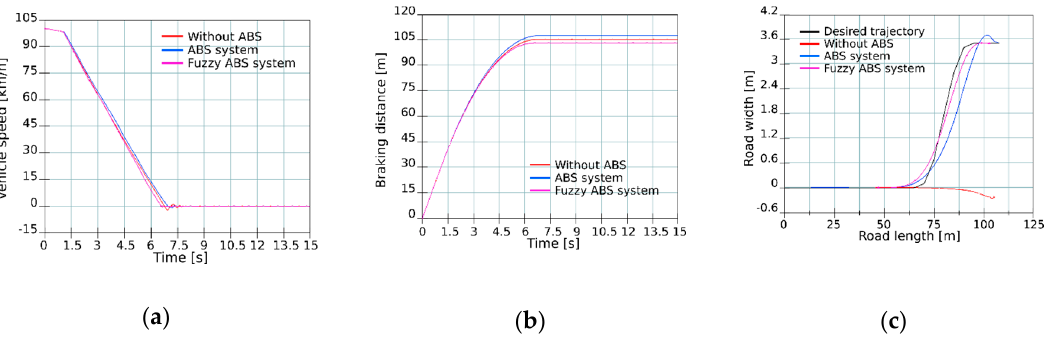
Figure 14. Road during maneuverability test.